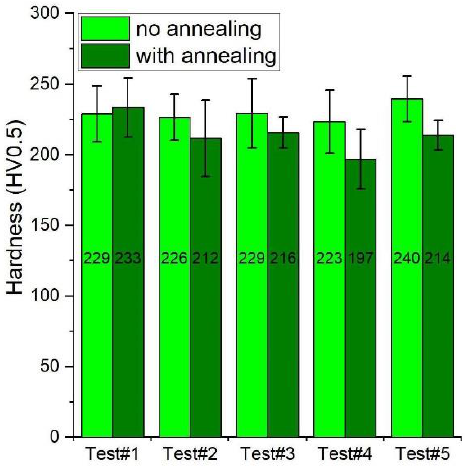
Figure 12. Change in microhardness after annealing to remove thermal vacancies of samples obtained by the PAIS method. Table 5. Results of statistical tests of the hardness of specimens with and without annealing. Without Annealing With